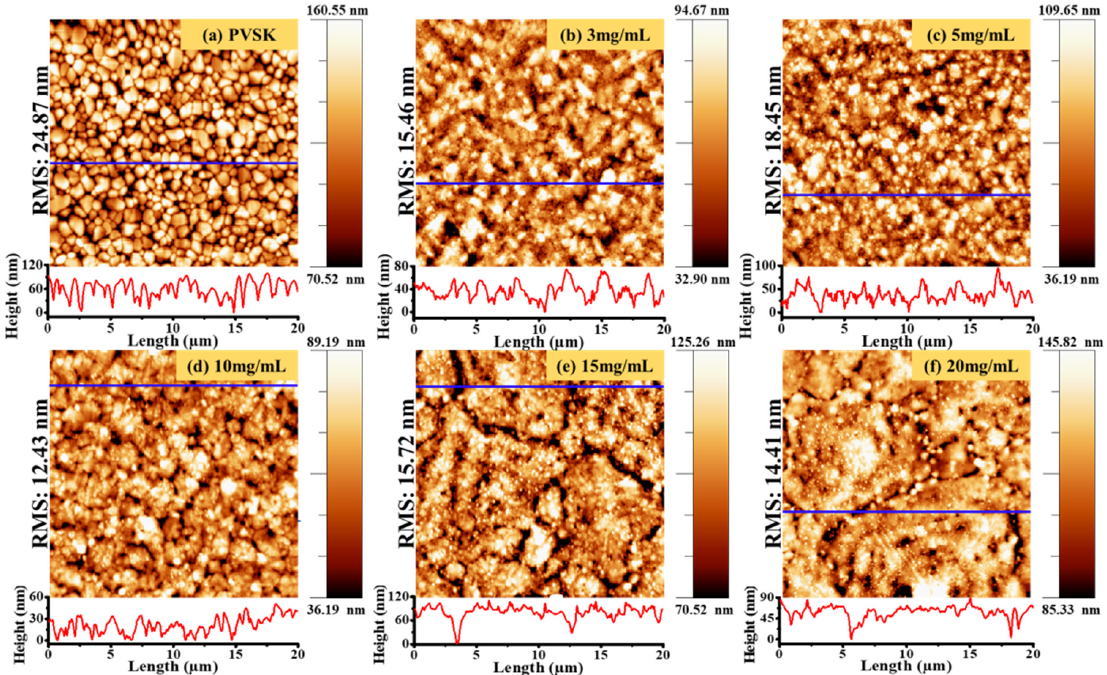
Figure 5. AFM images of perovskite films fabricated with different concentrations of NH 2 -POSS. The height profiles correspond to the height variation of the blue line in the AFM images.